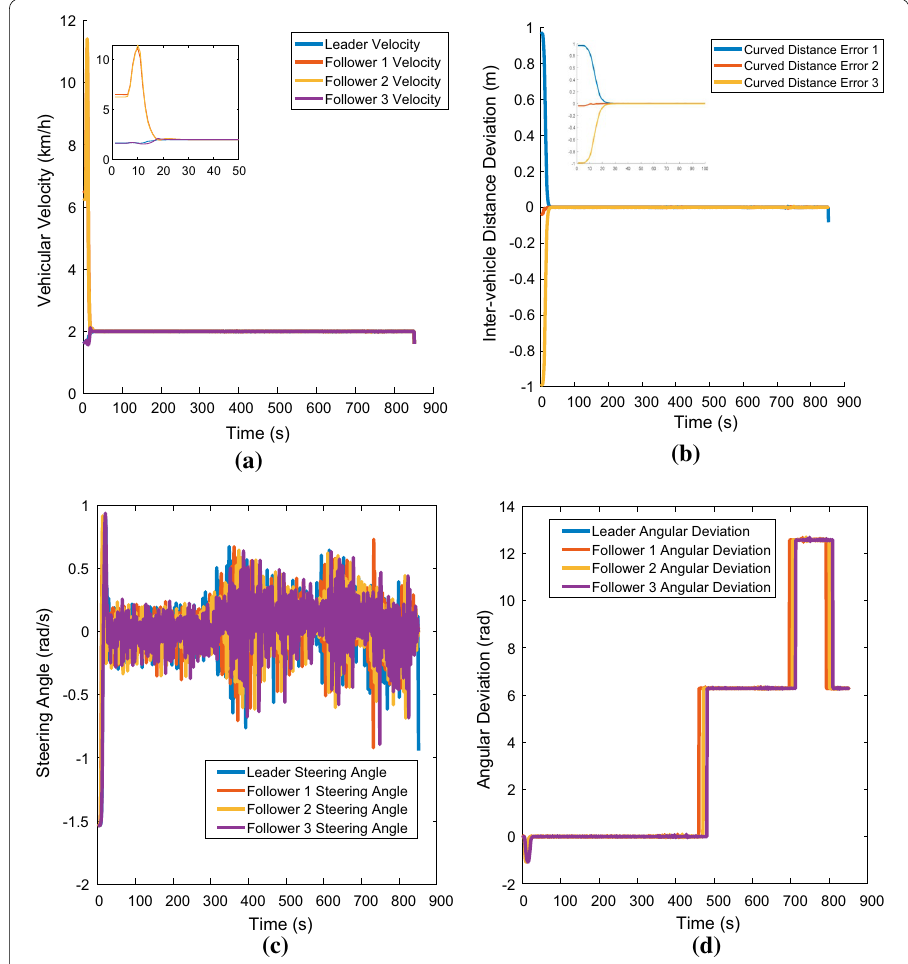
Fig. 6 Decentralized control under PLF: a vehicular velocity; b vehicular distance error; c steering angle; d angular